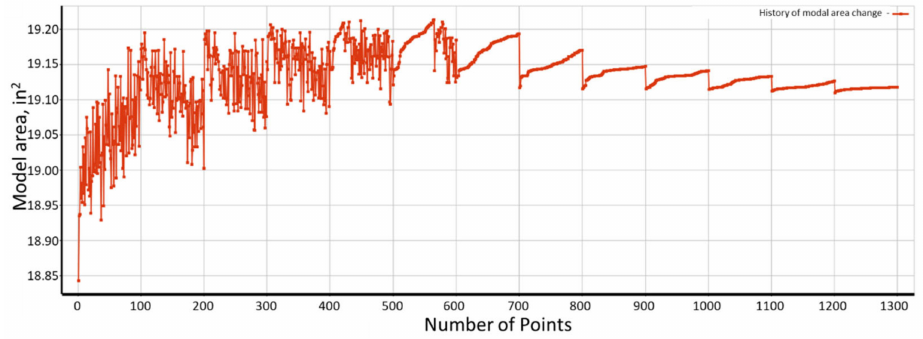
Figure 18. Convergence history for model